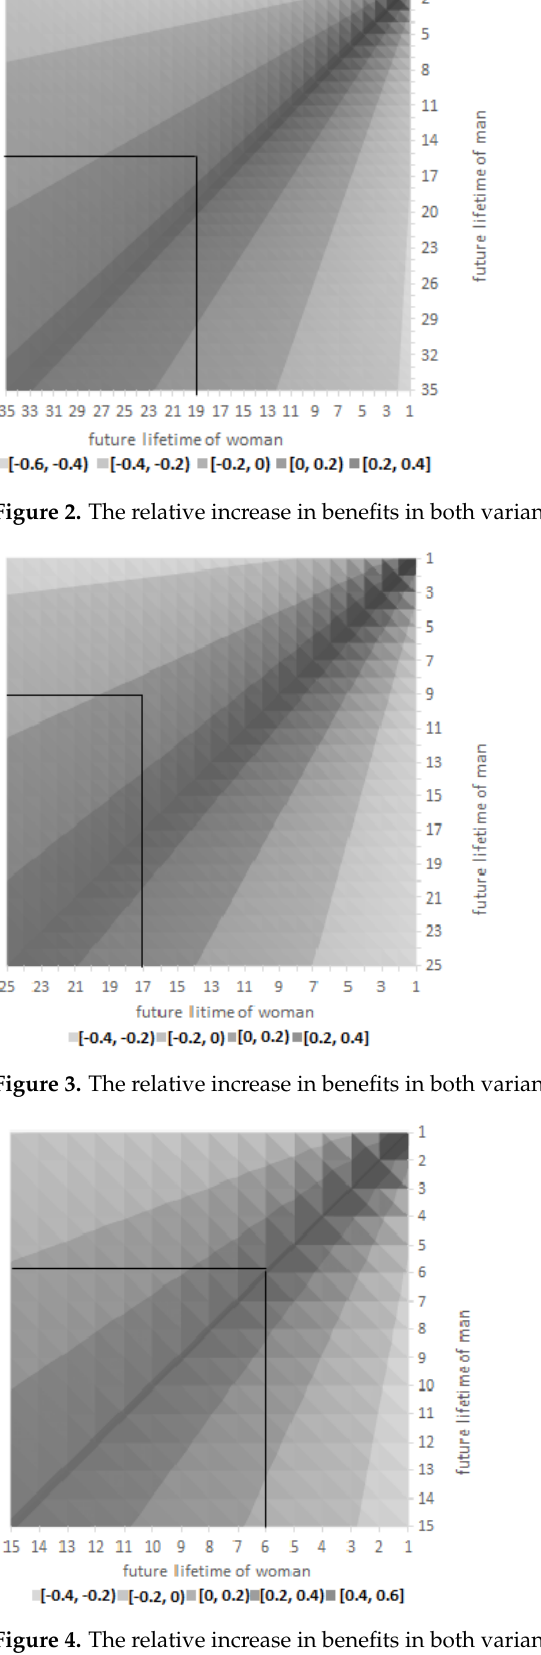
Figure 4. The relative increase in benefits in both variants for spouses aged 85.